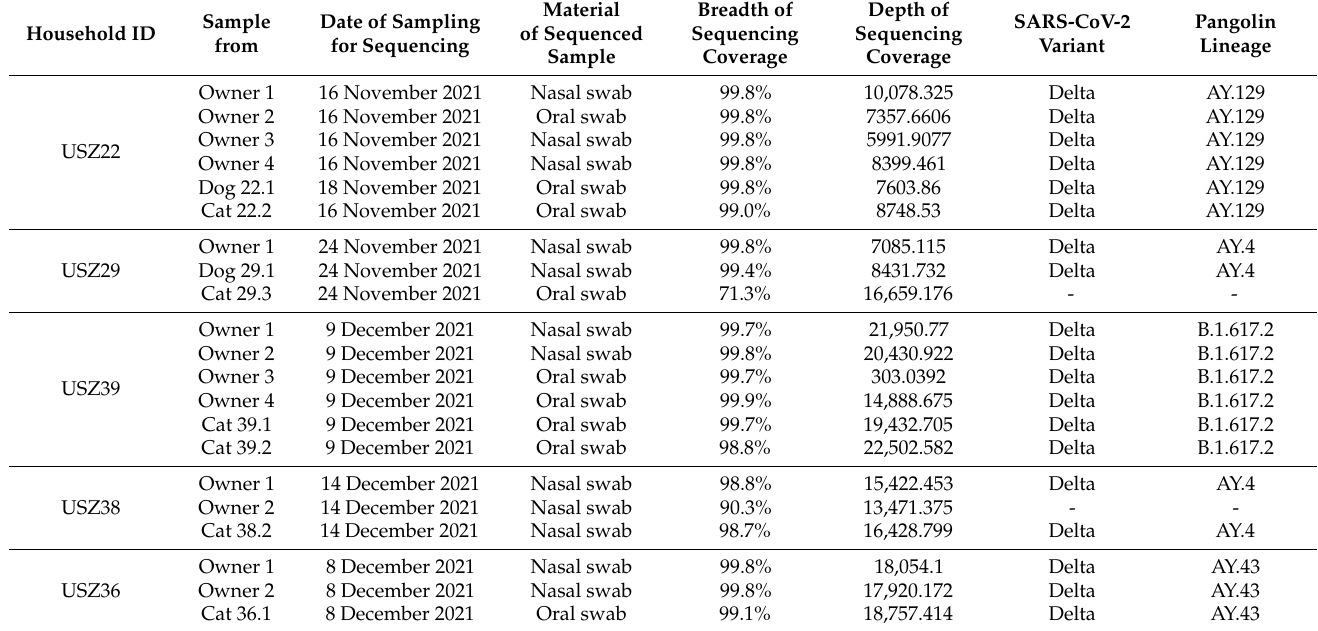
Table 6. Results from sequencing of samples from RT-qPCR-positive individuals: variant and pangolin lineage